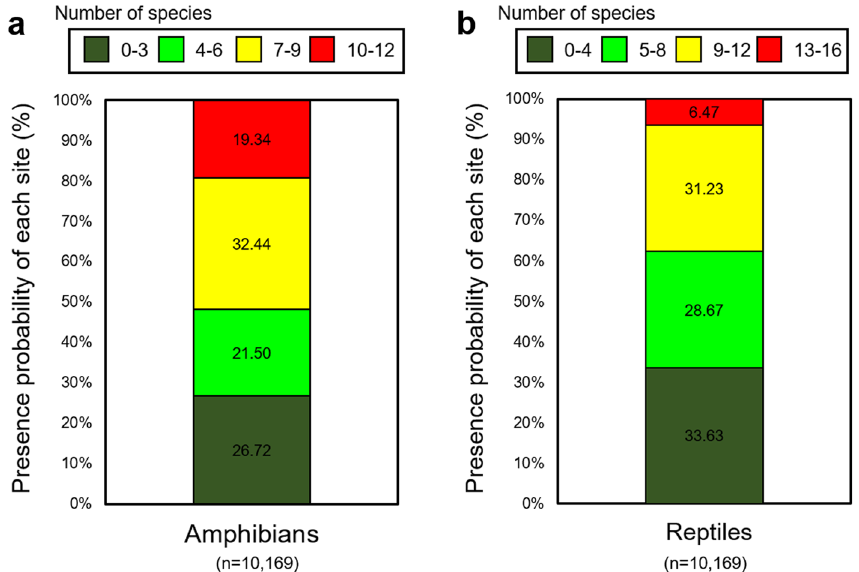
Figure 5. The ecological conservation area ranges and overlap of predicted presence/absence distributions of ( a ) amphibian and ( b ) reptile species in South Korea. This figure was generated using the program of Microsoft Excel and PowerPoint (MS, Microsoft Office 2016, WA, USA, https:// www. micro soft.